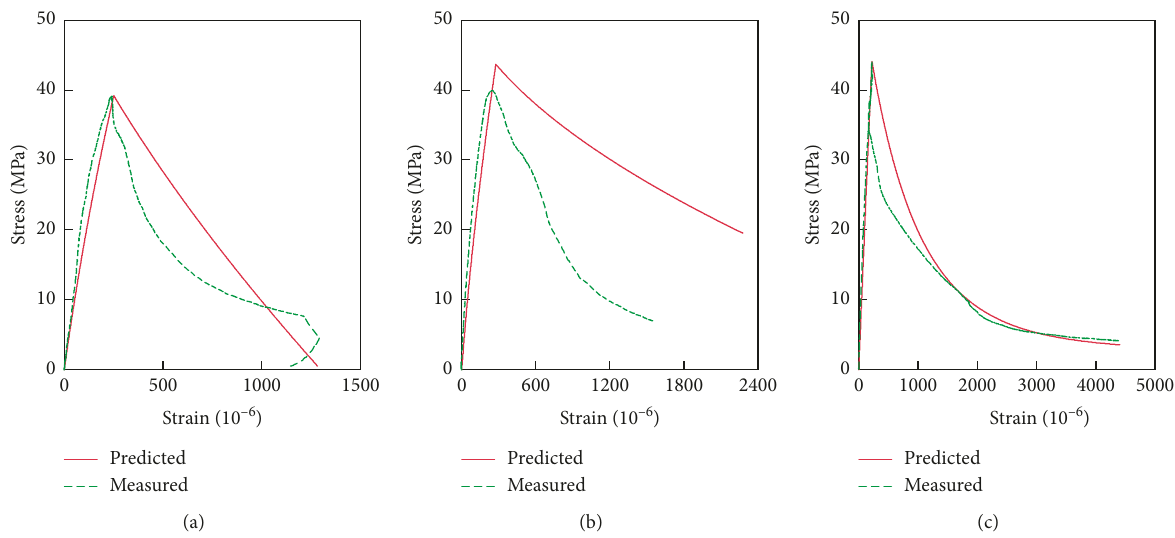
Figure 10: Predicted and measured stress-strain curves. (a) Sample of Group 1. (b) Sample of Group 2. (c) Sample of Group